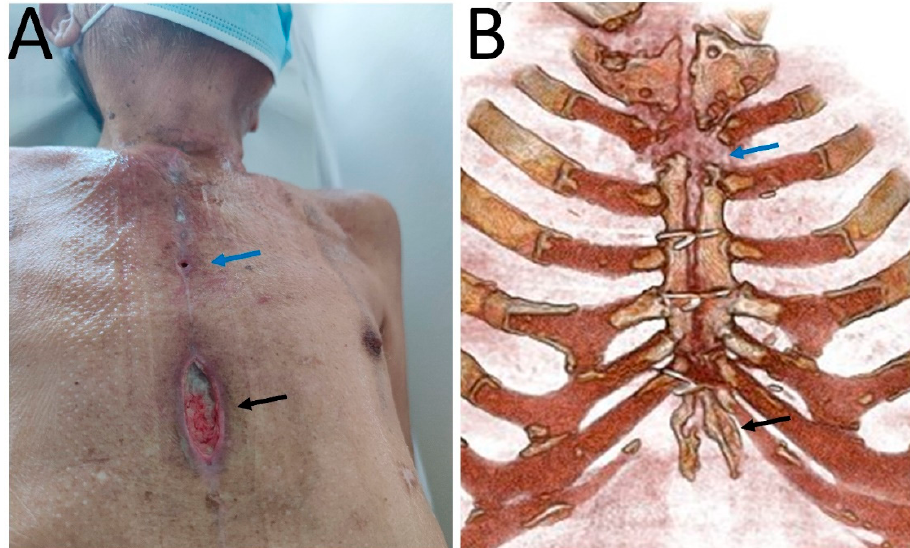
Figure 1. ( A ). Clinical picture of the two dehiscences in the upper and lower third of the sternotomy scar (arrows); ( B ). Three-dimensional volume-rendered CT images show sternal bone rarefaction areas in the upper and lower third of the sternum (arrows).